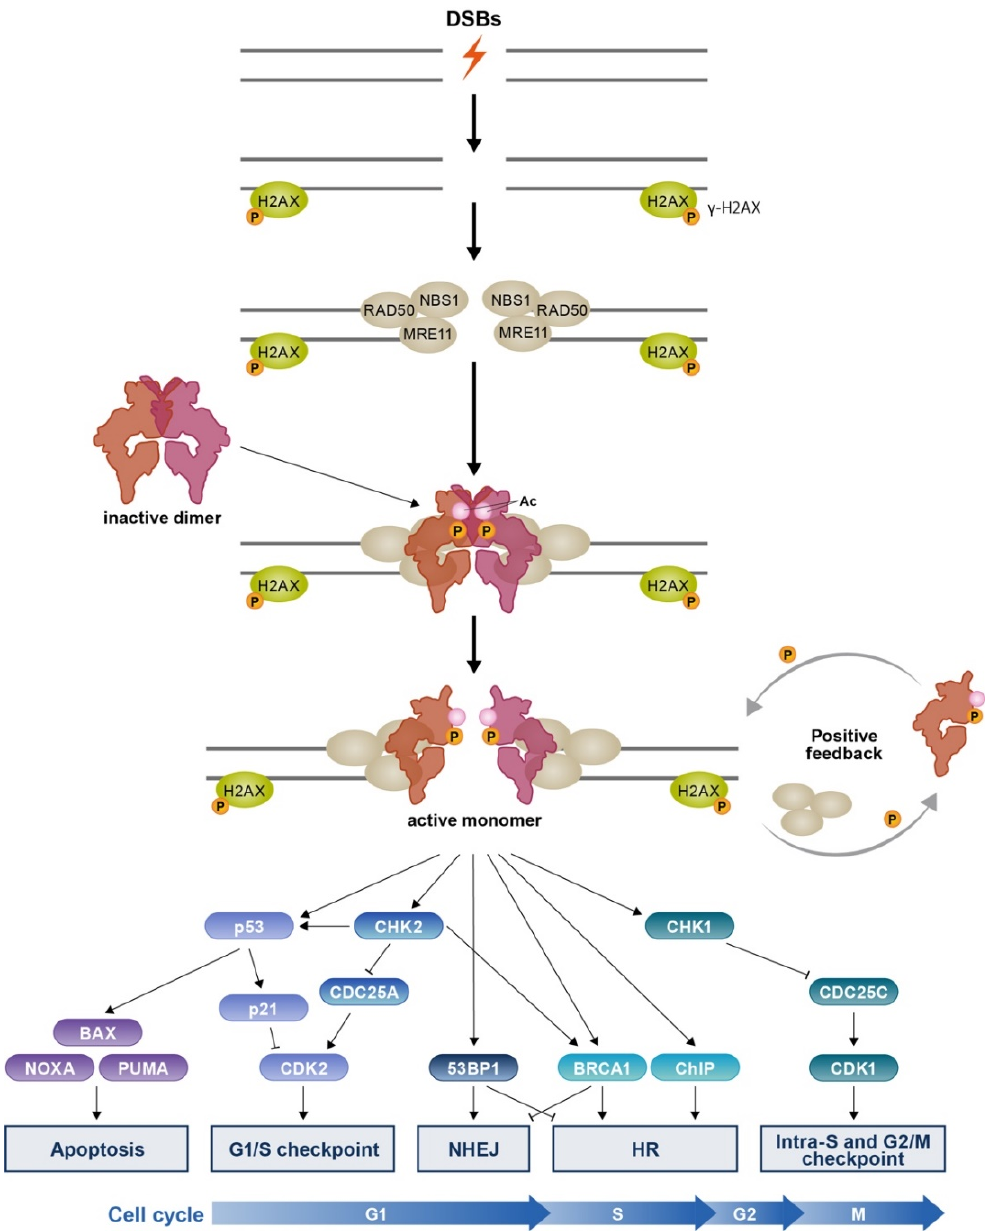
Figure 2. ATM signaling pathway in response to DSBs. ATM is recruited to sites of DSBs by the MRN complex. At the DSB site, ATM undergoes activation through acetylation by TIP60 and autophosphorylation. Direct interaction between the ATM and MRN complex is essential for ATM activation and monomerization. Activated ATM then phosphorylate H2AX surrounding the DSBs, which recruits more of the MRN complex to the site and forms a positive feedback loop between the MRN complex and ATM. ATM phosphorylates and activates a number of downstream targets that are essential for DNA damage repair (NHEJ and HR), cell cycle inhibition, and apoptosis. DNA damages are repaired through either NHEJ or HR in context of the cell cycle state.